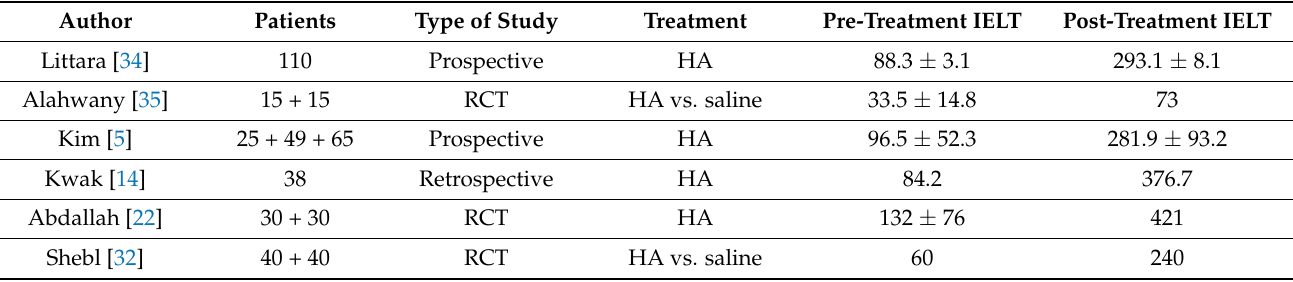
Table 3. Studies dealing with the use of HA to treat